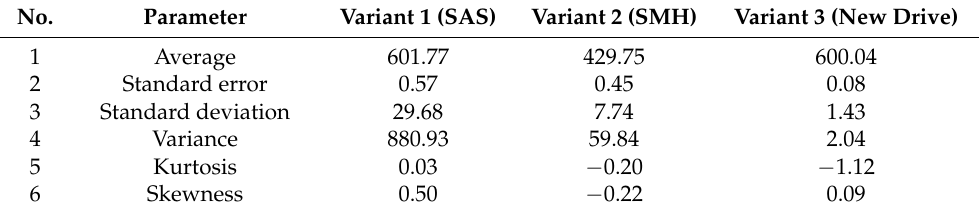
Table 1. Statistical description of the active power values (in kW) used in the simulation.